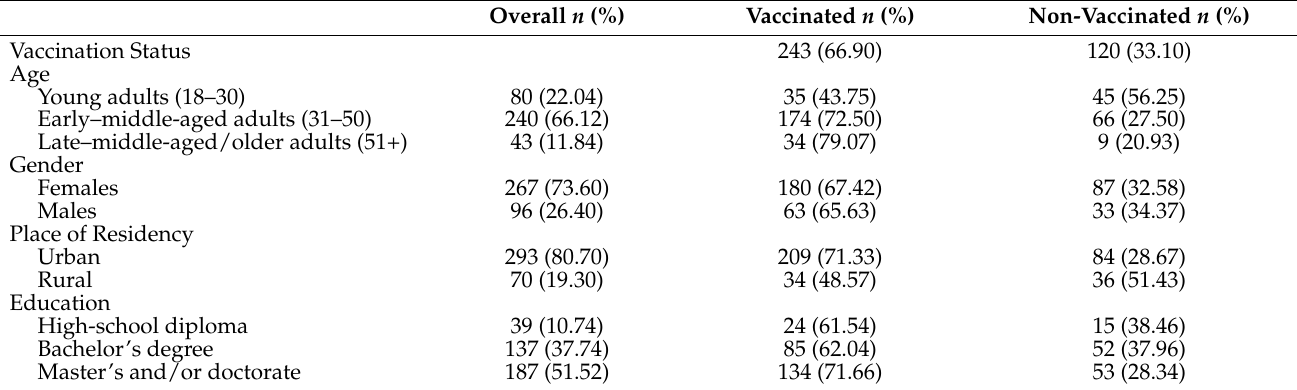
Table 1. Participants’